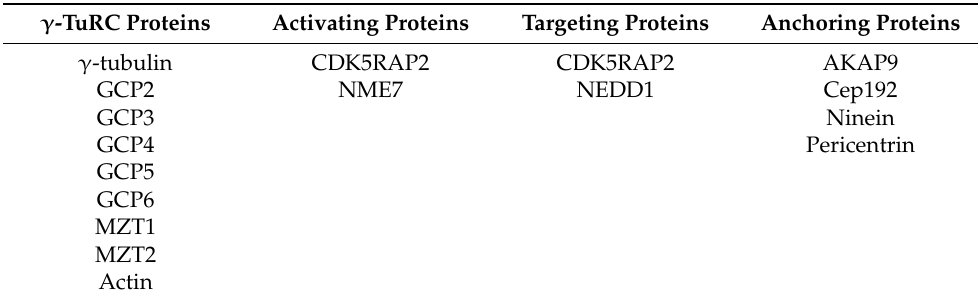
Table 1. Building components of γ -TuRC and regulatory proteins of centrosomal microtubule nucleation in interphase